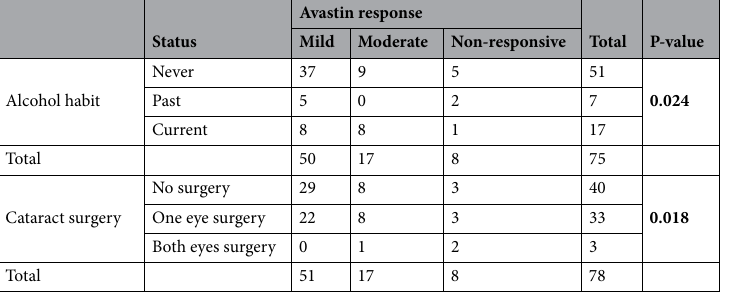
Table 1. Association of anti-VEGF response (based on number of anti-VEGF injections given during the course of disease) with daily living habits (Socio-demographic details) of AMD patients including alcohol consumption and cataract surgery in AMD patients. Mild- < 4 Avastin/year; Moderate- ≥ 5 Avastin/year; Non- responsive- ≥ 5 Avastin/year and continuous for > 36 months.